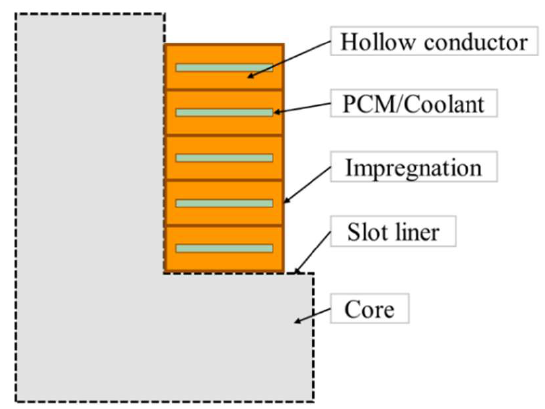
Figure 13. Schematic of hollow conductors [37].